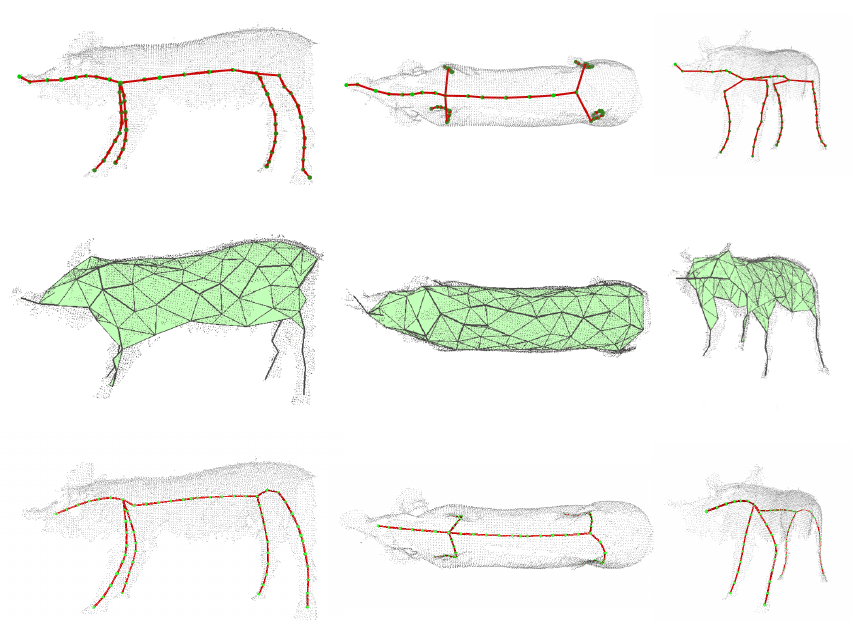
Figure 10. Visualization of a skeleton of a live pig effectively extracted by our method and another extracted by the L 1-median method. The pictures in the first line show the skeleton extracted by our method, and the pictures in the second line show the skeleton extracted by L 1-median.